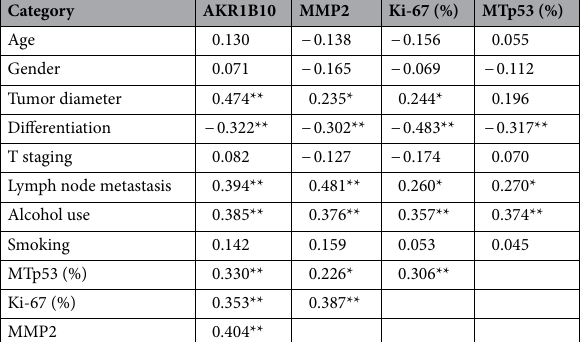
Table 3. Spearman’s correlation analysis of AKR1B10, Ki-67, MTp53, and MMP2 expression and clinical indicators. AKR1B10 aldosterone reductase family 1 member B10, MTp53 mutant p53, MMP2 matrix metalloproteinase 2. * P < 0.05 ** P <